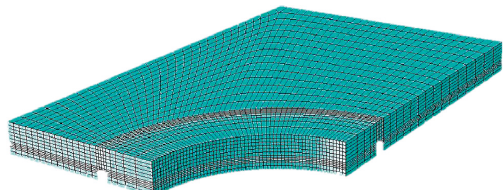
Figure 23: Over view of plate and shape of meshing done.